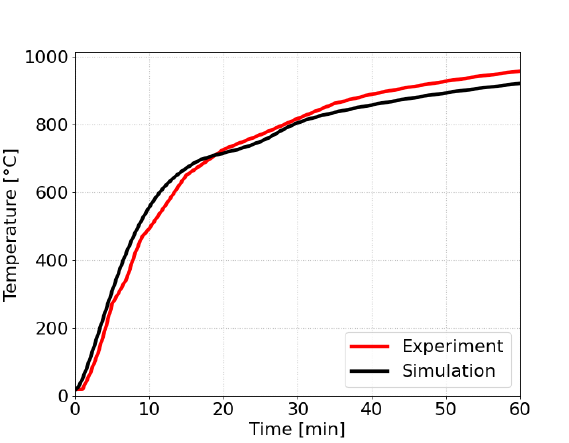
Figure 14. Comparison of experimental and simu- lated temperatures for beam protected with two layers of 22 mm OSB panels until the time when the protec- tion fell off.